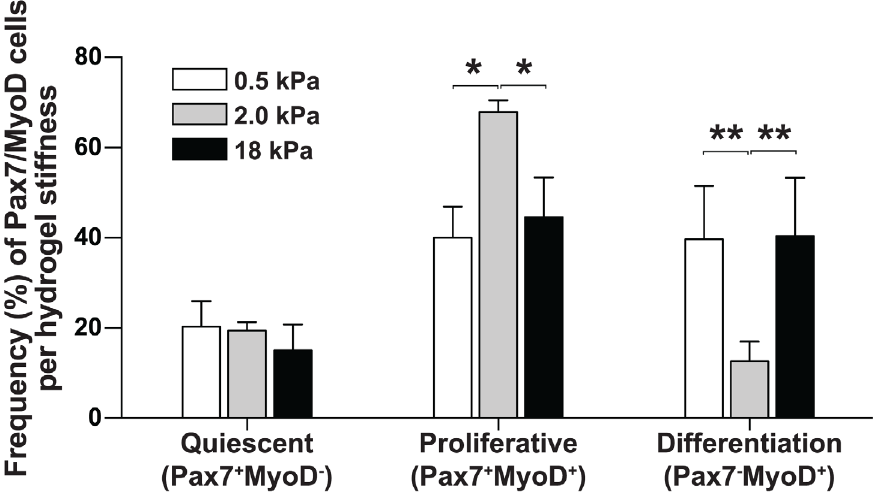
Fig 4. Hydrogels mimicking myofiber stiffness recapitulate MPC behavior. Histograms showing the frequency of quiescent, proliferative, and differentiating MPCs (Pax7 + MyoD - , Pax7 + MyoD + and Pax7 − MyoD + , respectively), as a function of hydrogel stiffness (0.5, 2.0, and 18 kPa). Primary myoblasts from adult ( n = 5) mice were used for this experiment. Cells were plated and grown for 48 h. The cells were then fixed and stained with DAPI and immunostained with Pax7 and MyoD antibodies. We counted the number of cells in five random fields in four plates for each stiffness preparation. All data are expressed as means ± SEM ( * p < 0.05; ** p <